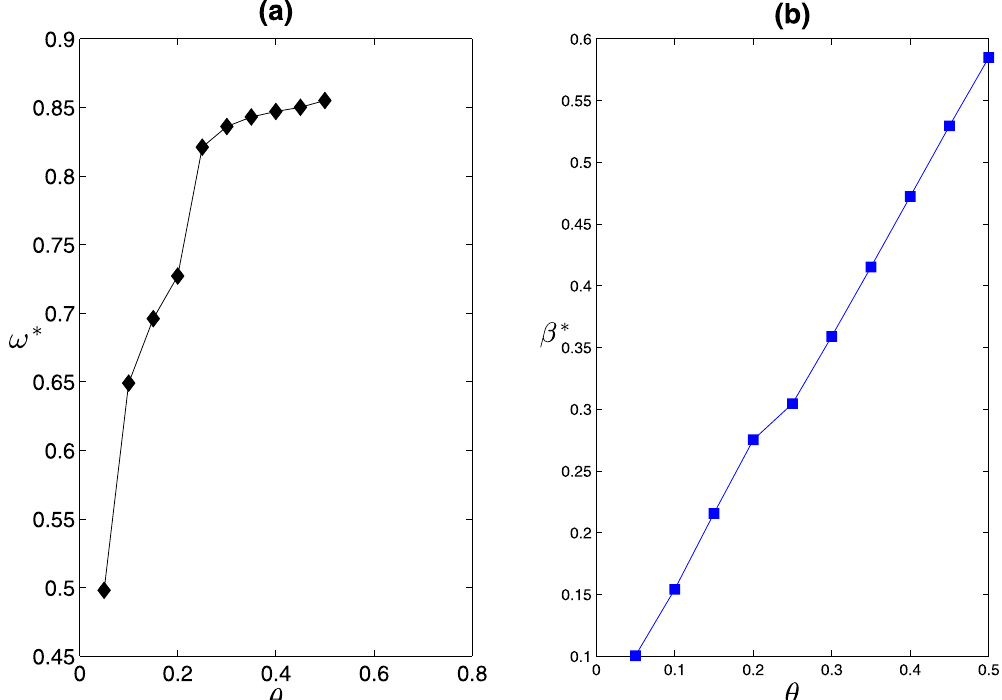
Figure 9. The optimal disturbance range parameter ω * ( a ) and the optimal disturbance strength parameter β * ( b ) versus the cost constraint parameter θ . The original network is the same as the one we used in Fig. 2. The disturbance effect is obtained based on the structural robustness measure R .